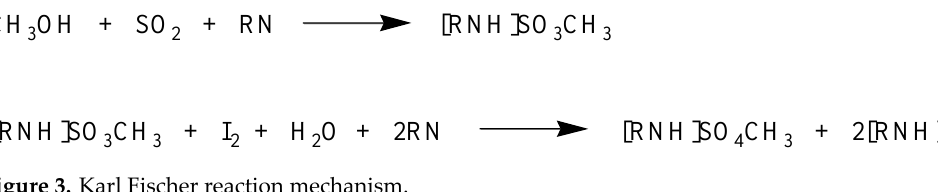
Figure 3. Karl Fischer reaction mechanism.